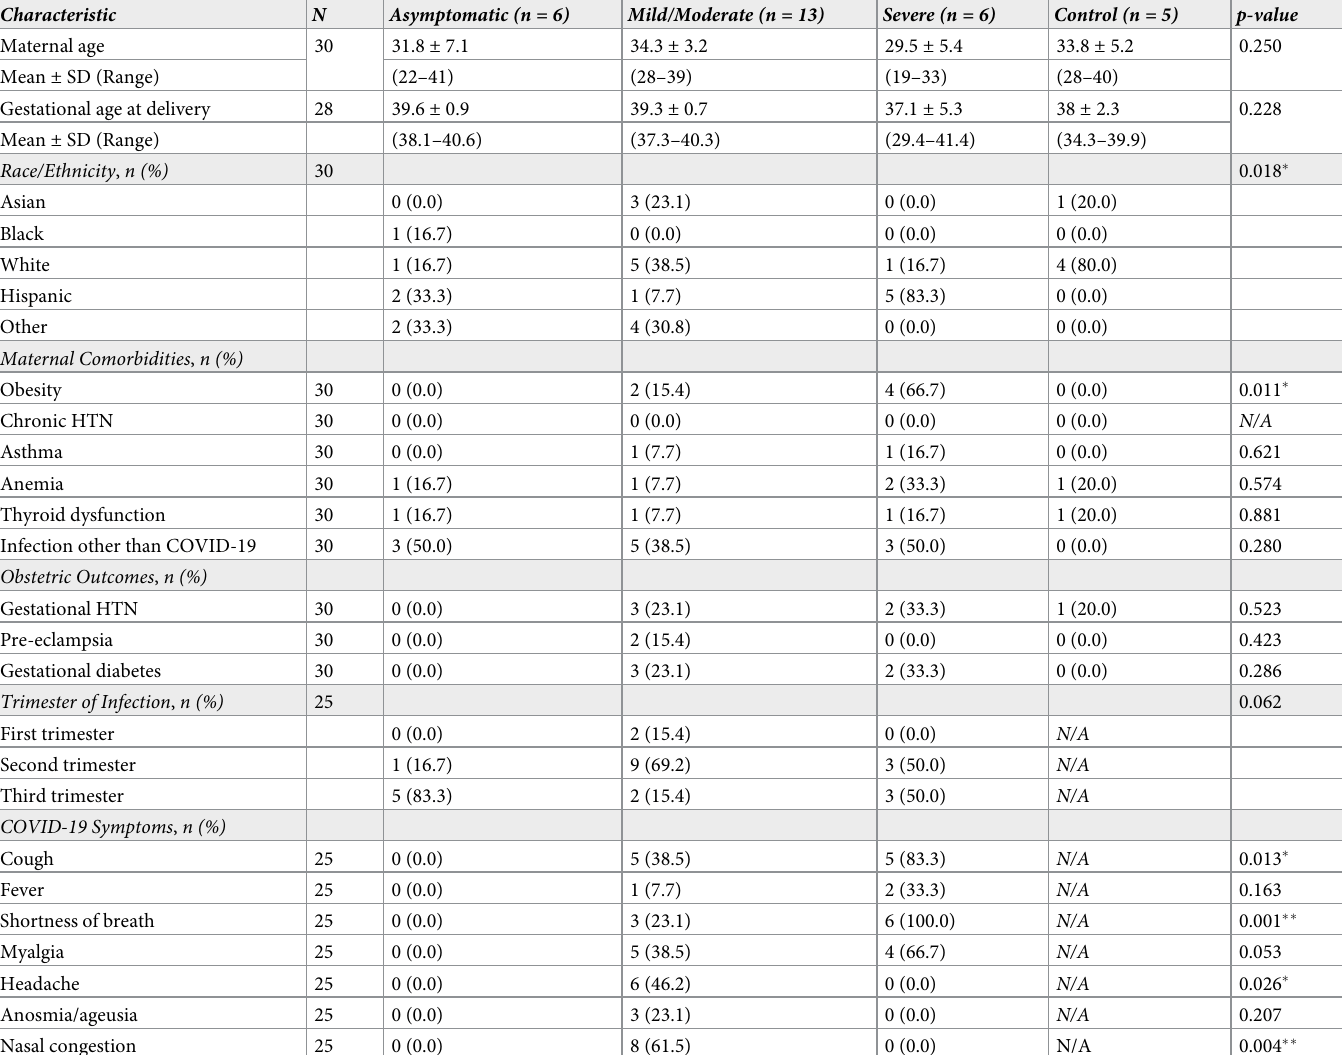
Table 1. Demographic and clinical characteristics categorized by severity of COVID-19